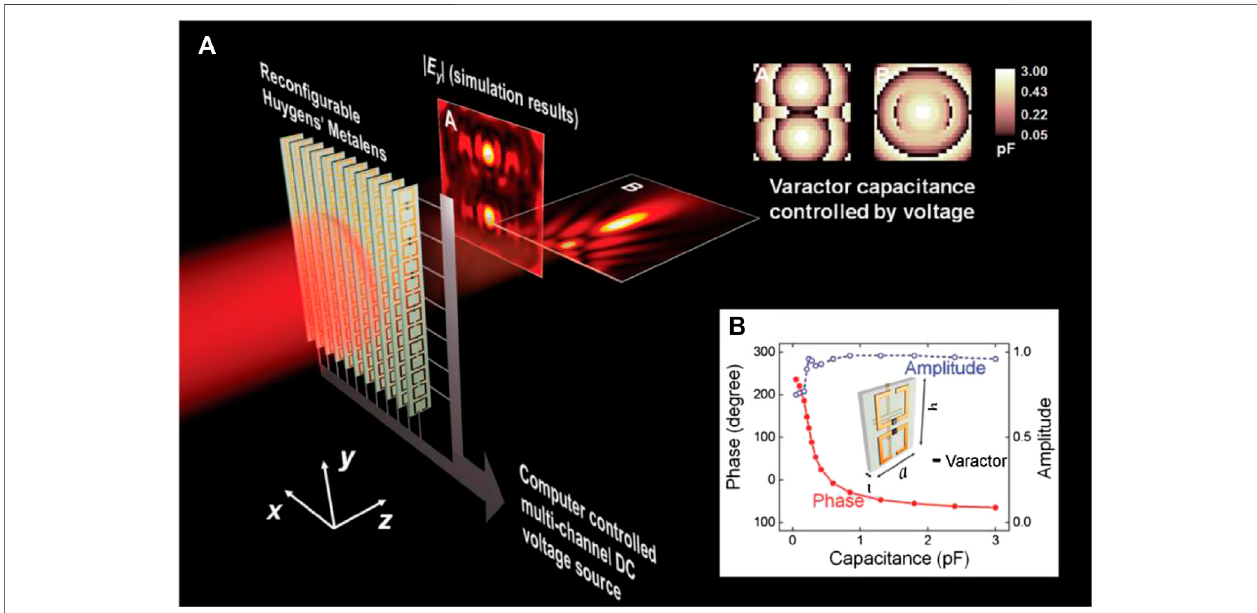
FIGURE 5 | Recon fi gurable Huygens ’ meta lens and characteristics of meta-atom. (A) Active Huygens ’ meta lens for dynamic EM wave focusing, of which meta- atomsarebiasedbycomputer-controlledmultichannelDCvoltagesources.Upper-rightinset:spatialdistributionsofcapacitancesusedtoachievetwofocalspotseither in x - y (A) orin x - z planes (B) basedonfull-wavesimulation. (B) Capacitance-dependentphaseandamplituderesponsesofEMwavetransmissionatthetargetfrequency of 6.9 GHz for incident electric and magnetic fi elds which are parallel to y - and x -axes, respectively. Source : reproduced from Ref. 65.